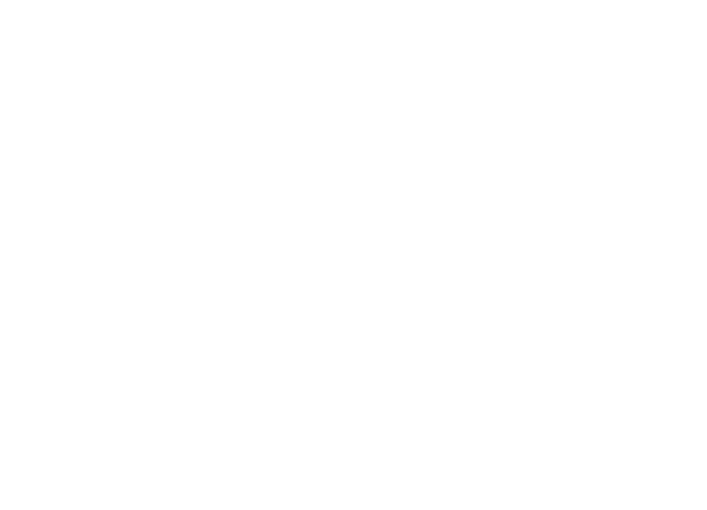
Figure 4. PSPNet network structure. Where: CONV represented the convolution operation of the feature map. POOL represented the pooling operation of the feature map.